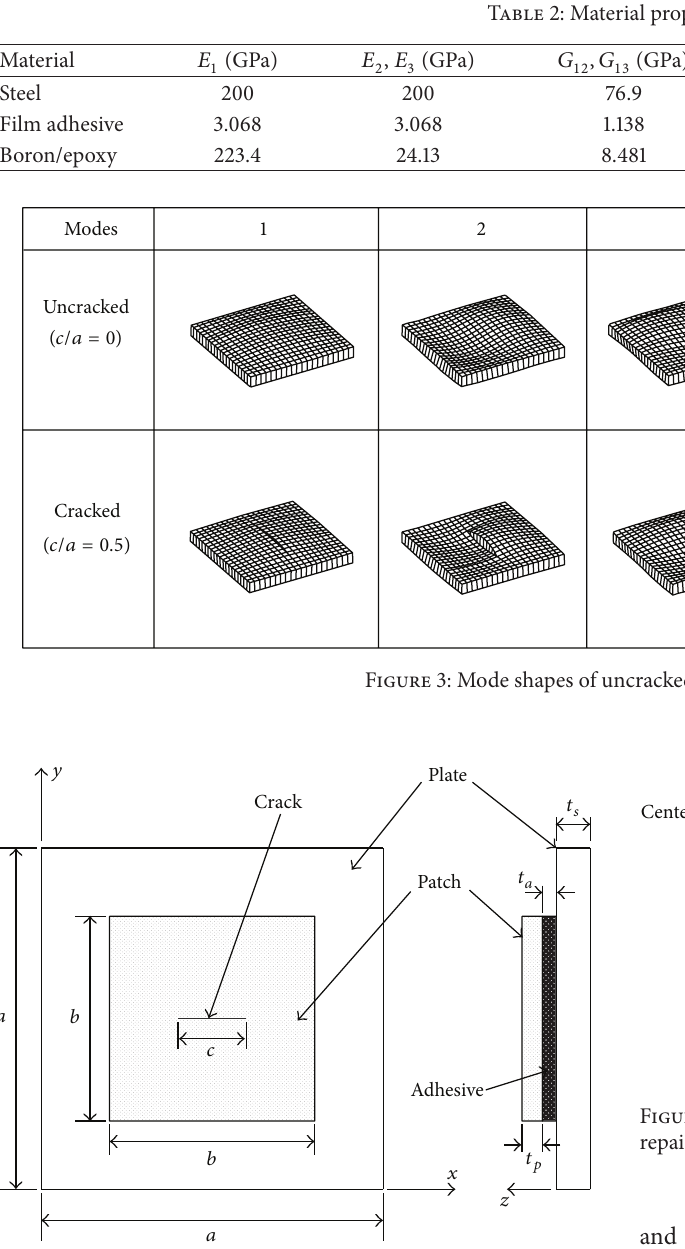
Figure4:Geometryofcenter-crackedplateswithexternallybonded repairs.